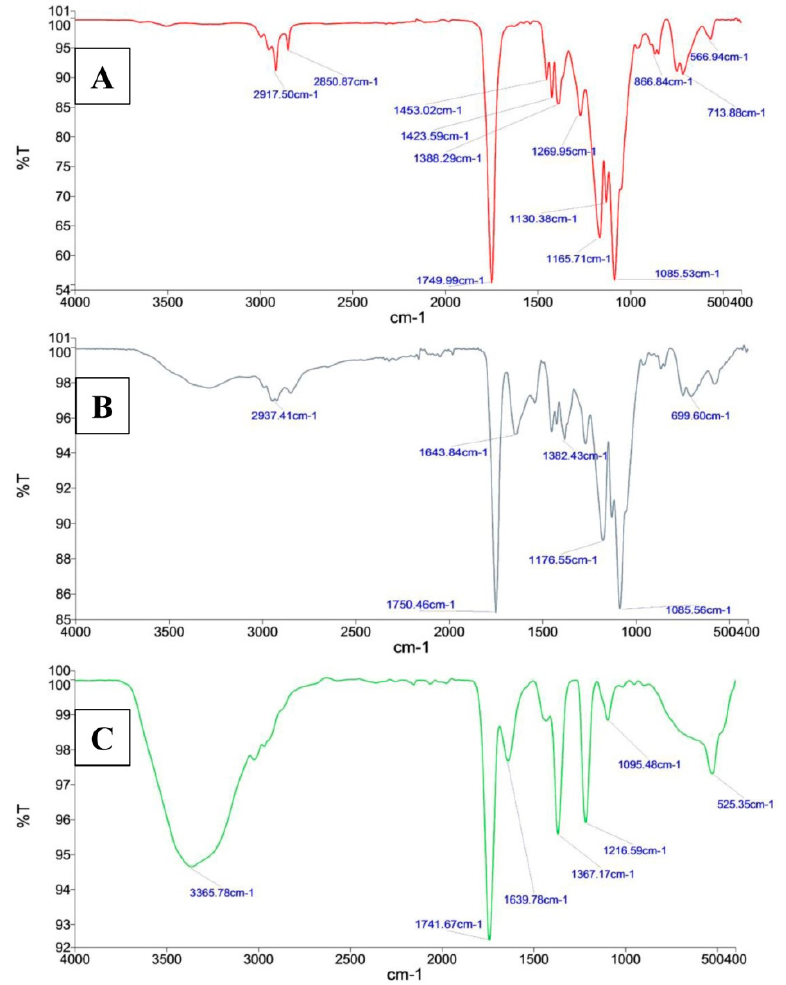
Figure 3. FTIR spectra of ( A ) void PLGA NPs, and ( B ) PLGA ‐ PEI NPs and ( C ) PLGA ‐ PEI ‐ EPI ‐ PTX NPs.